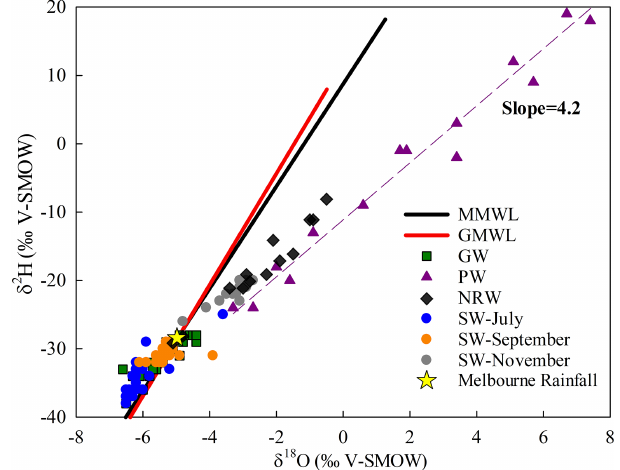
Figure 4. Stable isotope ratios of water samples in the upper Wimmera River. GMWL = global meteoric water line ( δ 2 H = 8.2 × δ 18 O + 11.3‰, as defined by Rozan- ski et al., 1993); MMWL = Melbourne meteoric water line ( δ 2 H = 7.4 × δ 18 O + 8.6‰, as defined by Hughes and Craw- ford, 2012). GW = regional groundwater; PW = pool water; NRW = near-river water; SW = stream water. The dashed line is the best fit for the pool water data. Data from Tables S1 and S2.